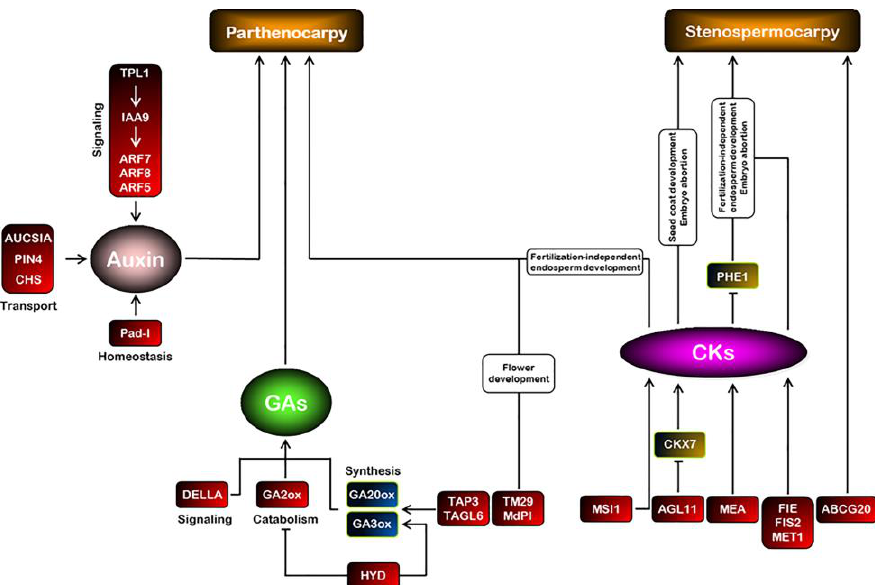
Figure 2. Schematic model of hormonal regulation of seedless fruit set. Parthenocarpy is obtained either by exogenous treatments or by genetic manipulations of phytohormones. Gene names in red boxes represent the gene loss-of-function mutation or downregulation that causes parthenocarpy or stenospermocarpy seedlessness. The gene name in the red boxes could be identified in Table 1. GA20ox (GA 20 oxidase) and GA3ox (GA 3 oxidase), GA biosynthetic genes; GA2ox (GA 2 oxidase), a GA catabolic enzyme; CKX7 (cytokinin oxidases/dehydrogenases), a CK-degrading enzyme; and PHE1 (PHERES1), a type I MADS-box gene.